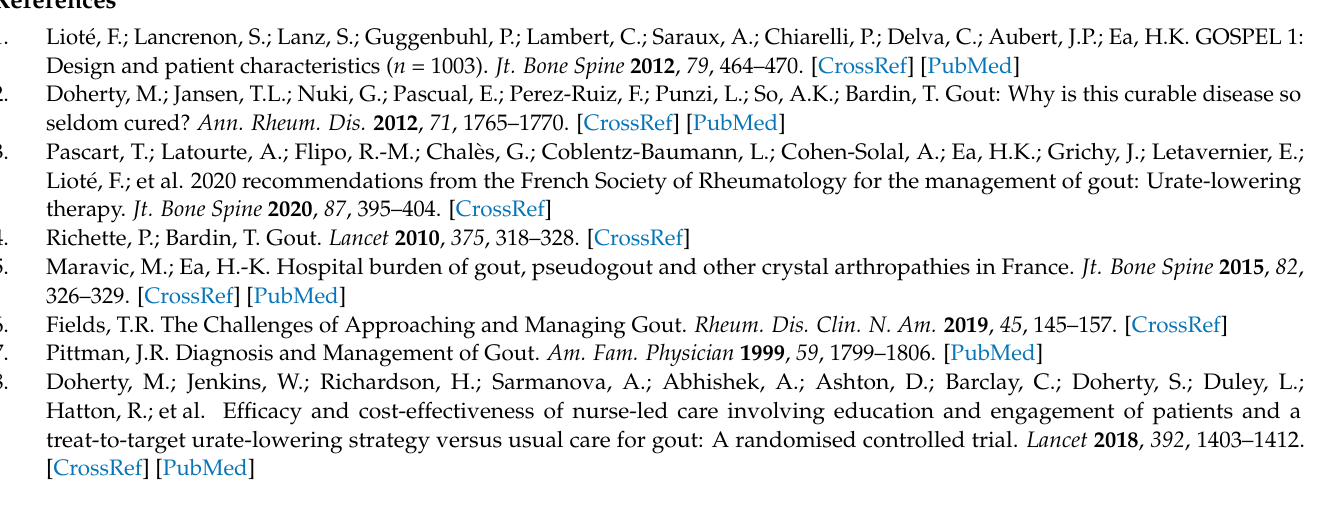
Table S2: Lost to follow-up patients characteristics. Table S3: Subgroup analysis to compare the